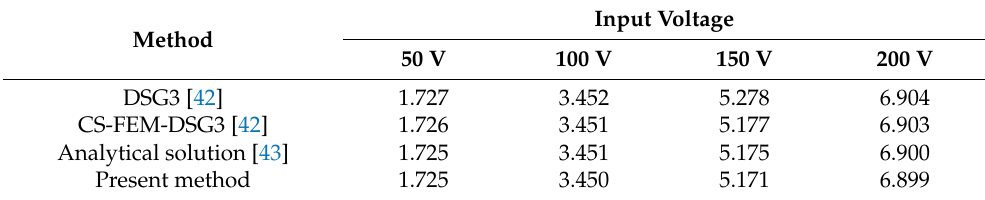
Table 4. Tip deflection of the piezoelectric bimorph beam with different input voltages ( × 10 − 2